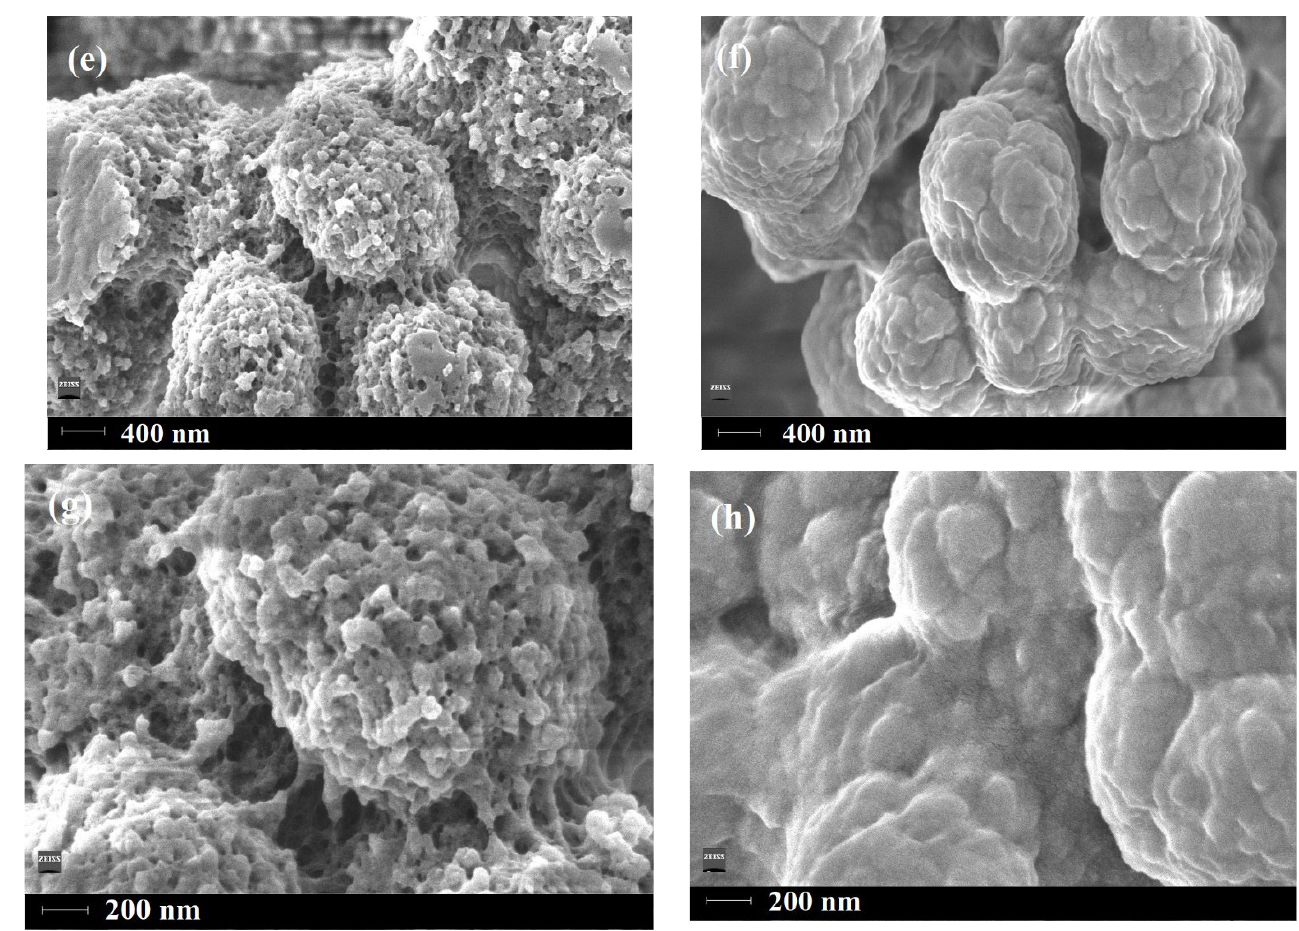
Figure 3. SEM micrographs of MIP ft ( a,c,e,g ) and NIP ( b,d,f,h ).